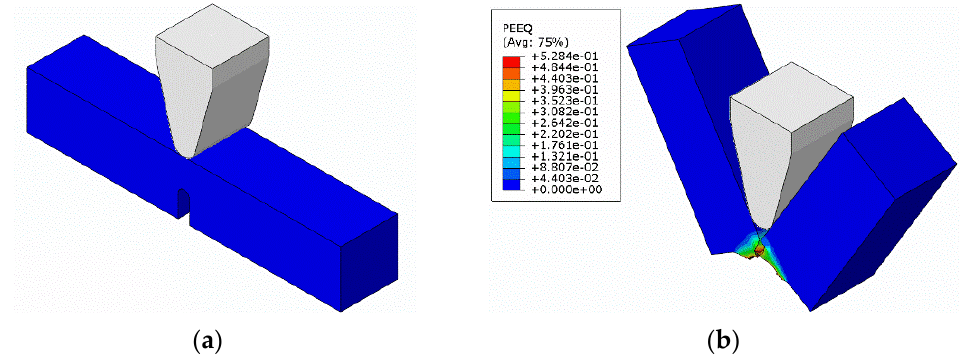
Figure 31. View of the impact strength simulation: ( a ) before impact; ( b ) after impact.